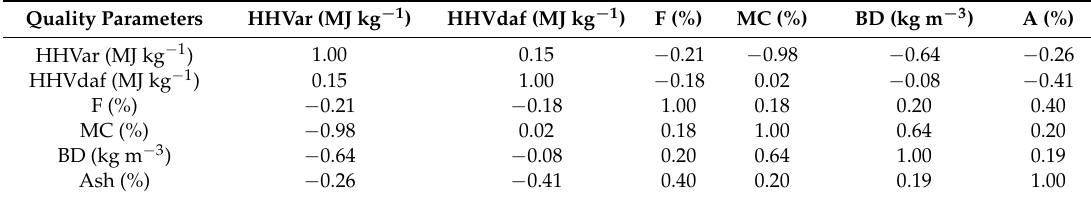
Table 4. Linear correlations r between quality parameters (HHVar: High Heating Value as received; HHVdaf: High Heating Value dry basis ash free; Fines: F; Moisture Content: MC; Bulk Density: BD; Ash on dry basis: